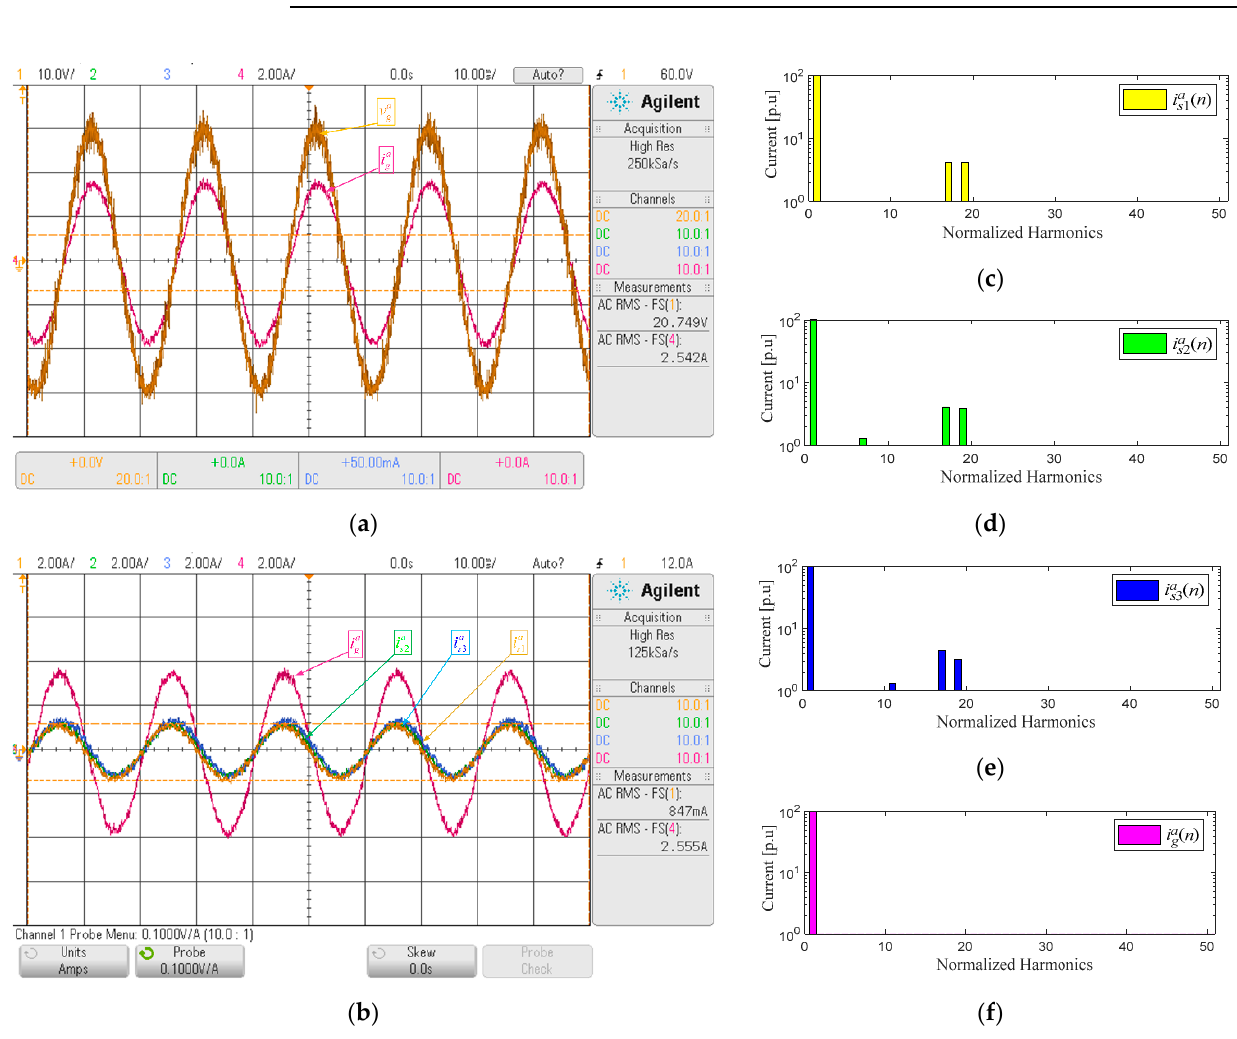
Figure 6. Key waveforms input current control: ( a ) input voltage (yellow) and current (magenta) v pa and i ga , ( b ) input current phase a i s1a (yellow), i s2a (green), i s3a (blue) and i ga (magenta), ( c ) harmonic